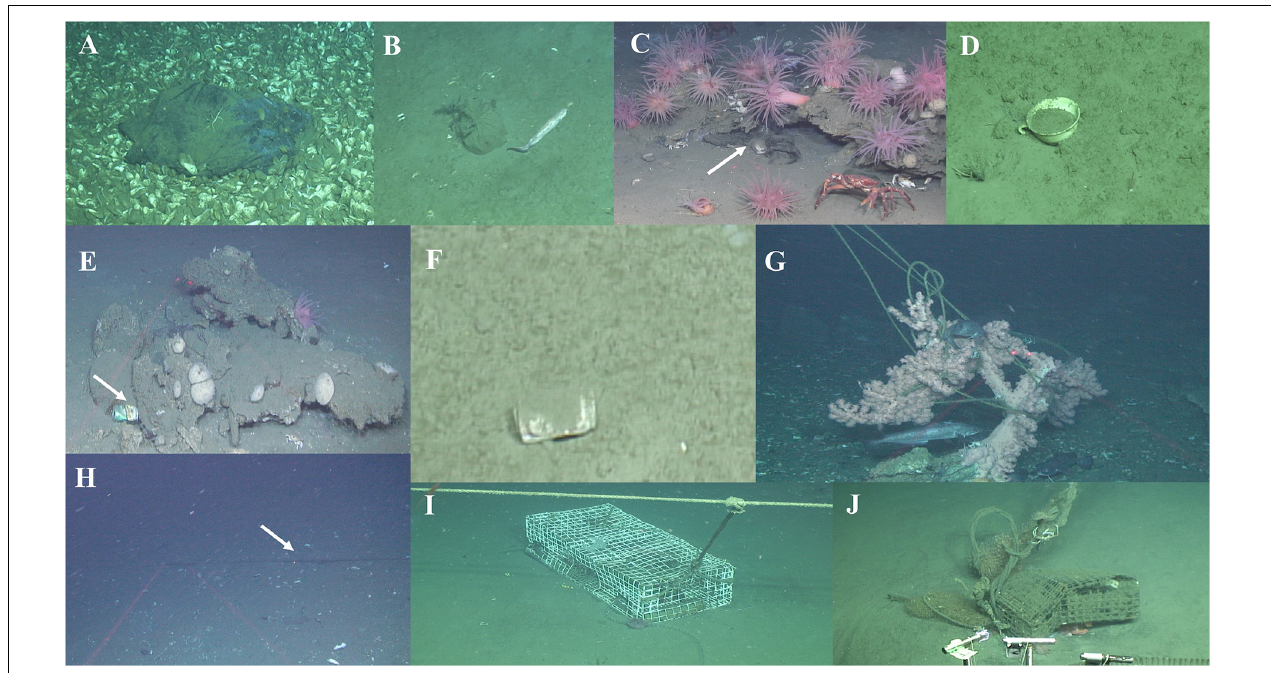
FIGURE 7 | Marine litter items at Baltimore (BC) and the Norfolk (NC) canyon seeps. Plastic bags (A,B) and teacup (D) at NC; plastic bag at BC (C) . Tin cans at BC (E) and NC (F) . Lost/abandoned fishing gear at the BC (G–J) ; note at (G) the large colony of Paragorgia arborea tangled in the abandoned